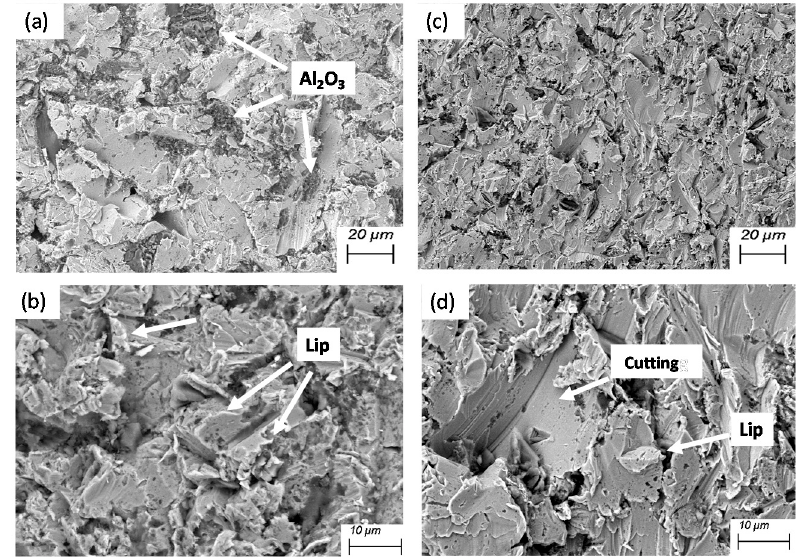
Figure 8 . Worn surface of the IN718-Ni coating. Erosion test process variables used: ( a , b ) erodent feed rate = 2 g/min, erodent size = 60 µm, impingement angle = 90° (parameters setup obtained in the optimization, see Table 10); ( c , d ) erodent feed rate = 5 g/min, erodent size = 90 µm, impingement angle = 30°.